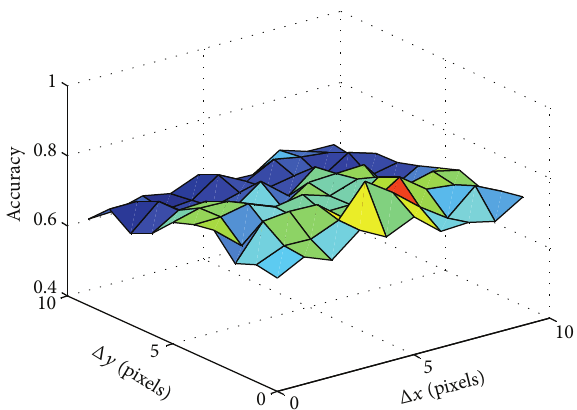
Figure 9: The relationship between shift length and the standard deviation.